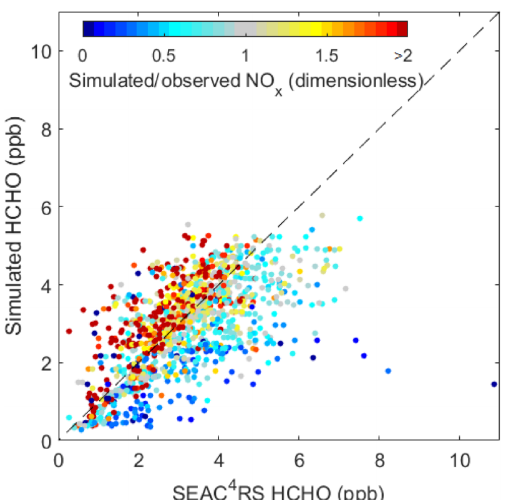
Figure 8. Comparison of simulated and observed HCHO concen- trations along the SEAC 4 RS flight tracks, using the model with op- timized isoprene emissions from the base inversion. The dashed line indicates 1 : 1 agreement. Data are the same as in Fig. 7 (upper mid- dle) but are colored by the local ratio of simulated to observed NO x